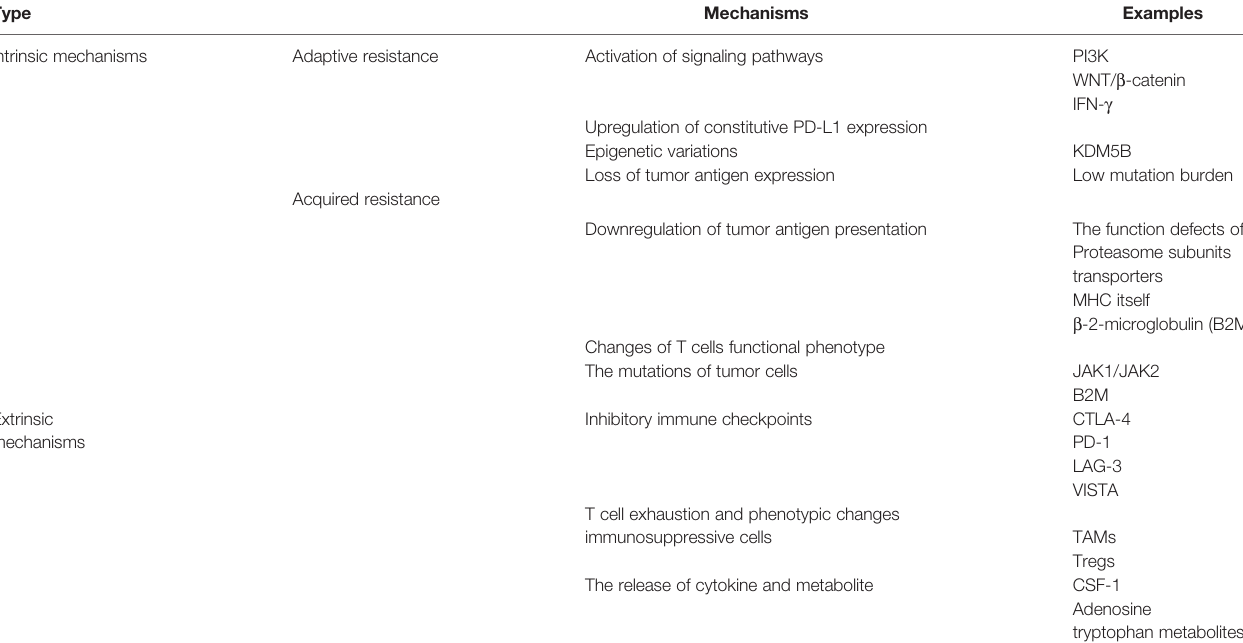
TABLE 1 | The potential mechanisms of immune resistance.